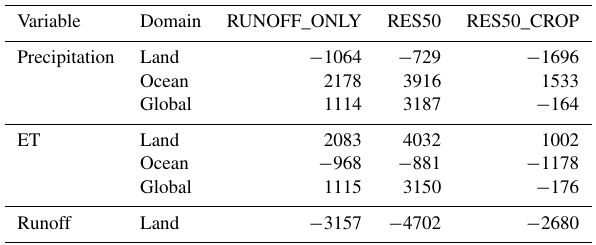
Table 1. Mean annual differences between EXP and REF for pre- cipitation, ET, and runoff (in km 3 yr − 1